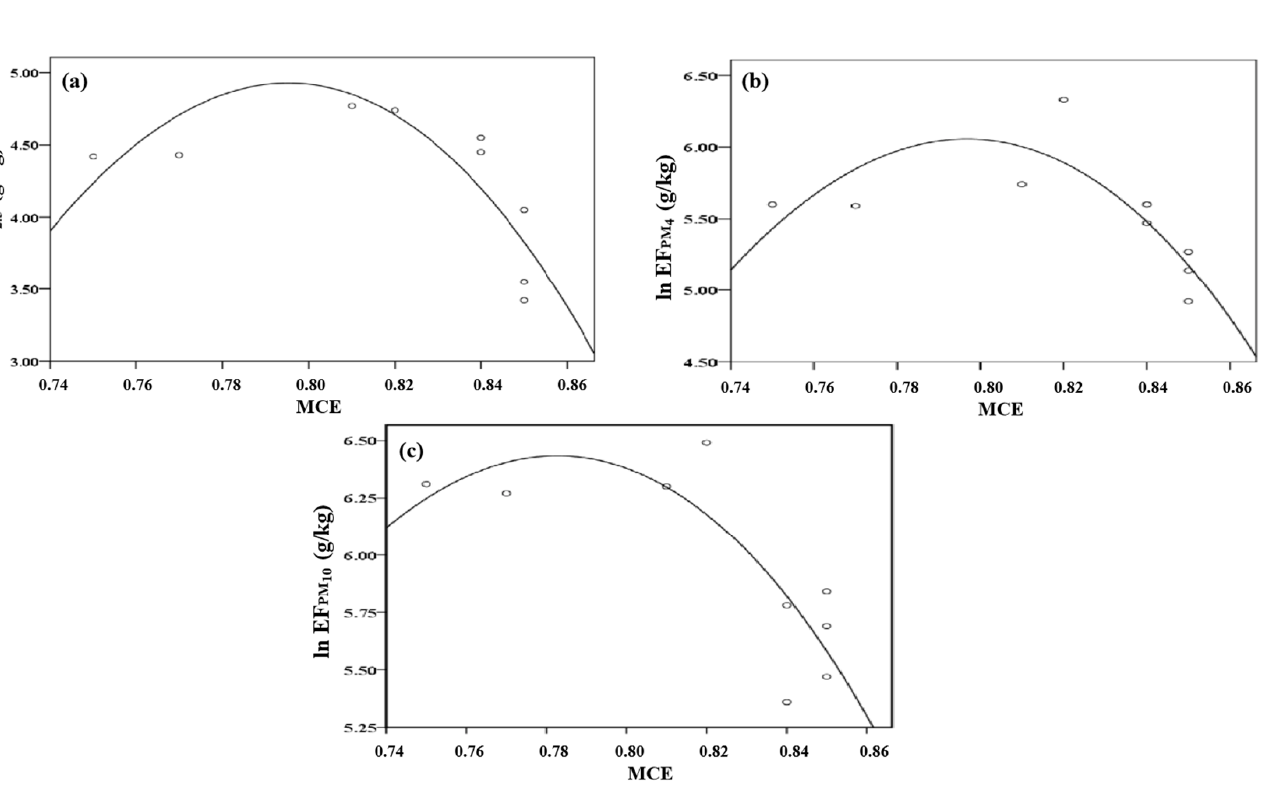
Figure 6. Relationship between EF and MCE: ( a ) fit between EF PM 2.5 and MCE; ( b ) fit between EF PM 4 and MCE; ( c ) fit between EF PM 10 and MCE.